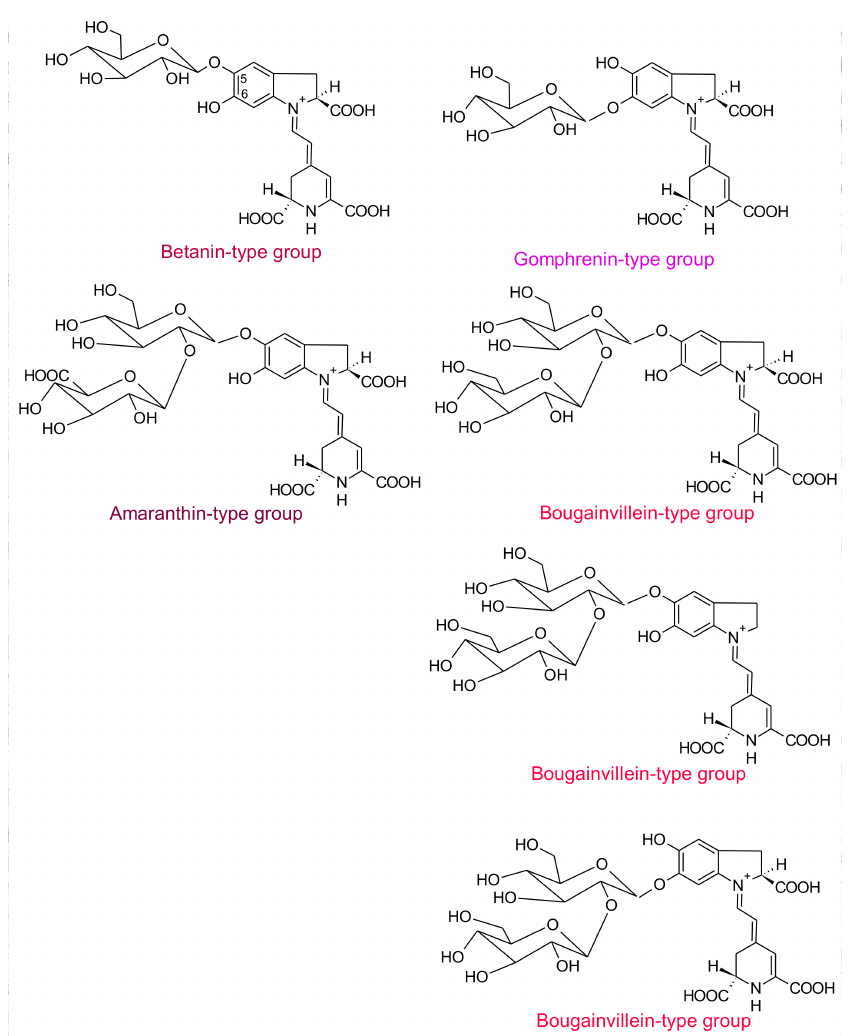
Figure 2. Example of structures of the different types of